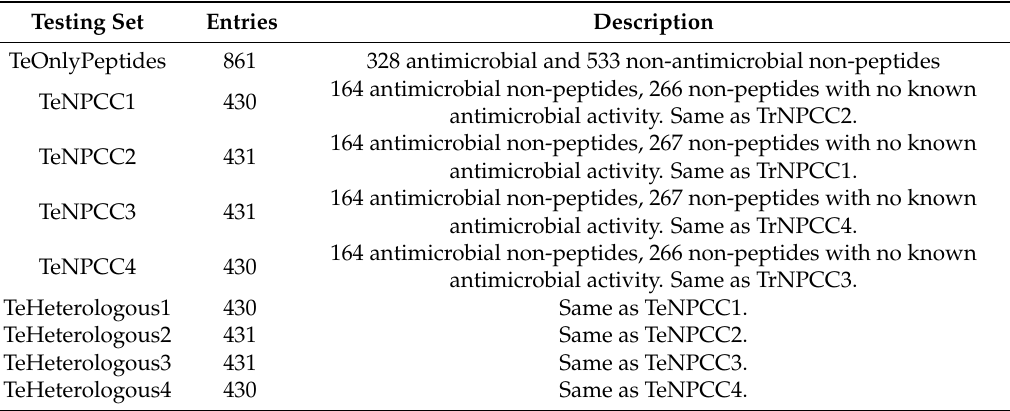
Table 2. Testing data